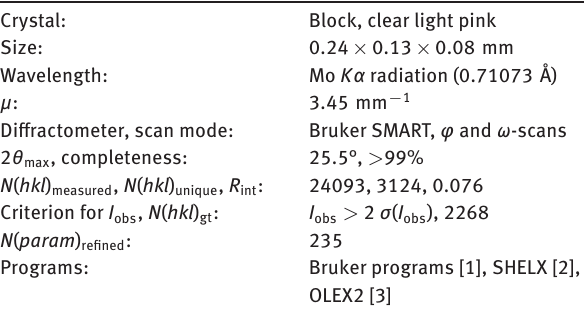
A part of the polmeric title crystal structure is shown in the figure. (The asymmetric unit is labelled only. ′ = x , 0.5 − y , 0.5 − z ; ′′ = 1 − x , 1 − y , − z .) Tables 1 and 2 contain details on crystal structure and measurement conditions and a list of the atoms including atomic coordinates and displacement